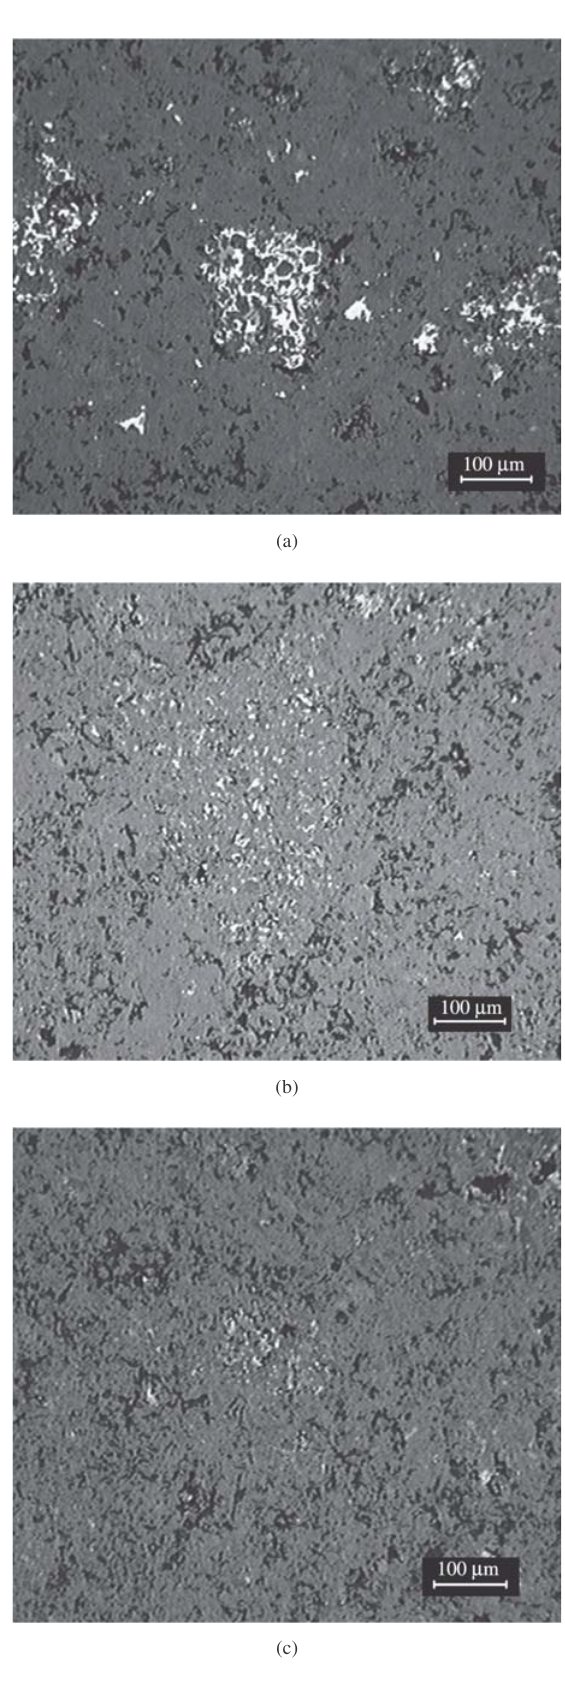
Figure 3. Optical micrographs of the polished surface after pyrolysis at: a) 1450 °C/2h; b) 1500 °C/2h; c)1600 °C/1